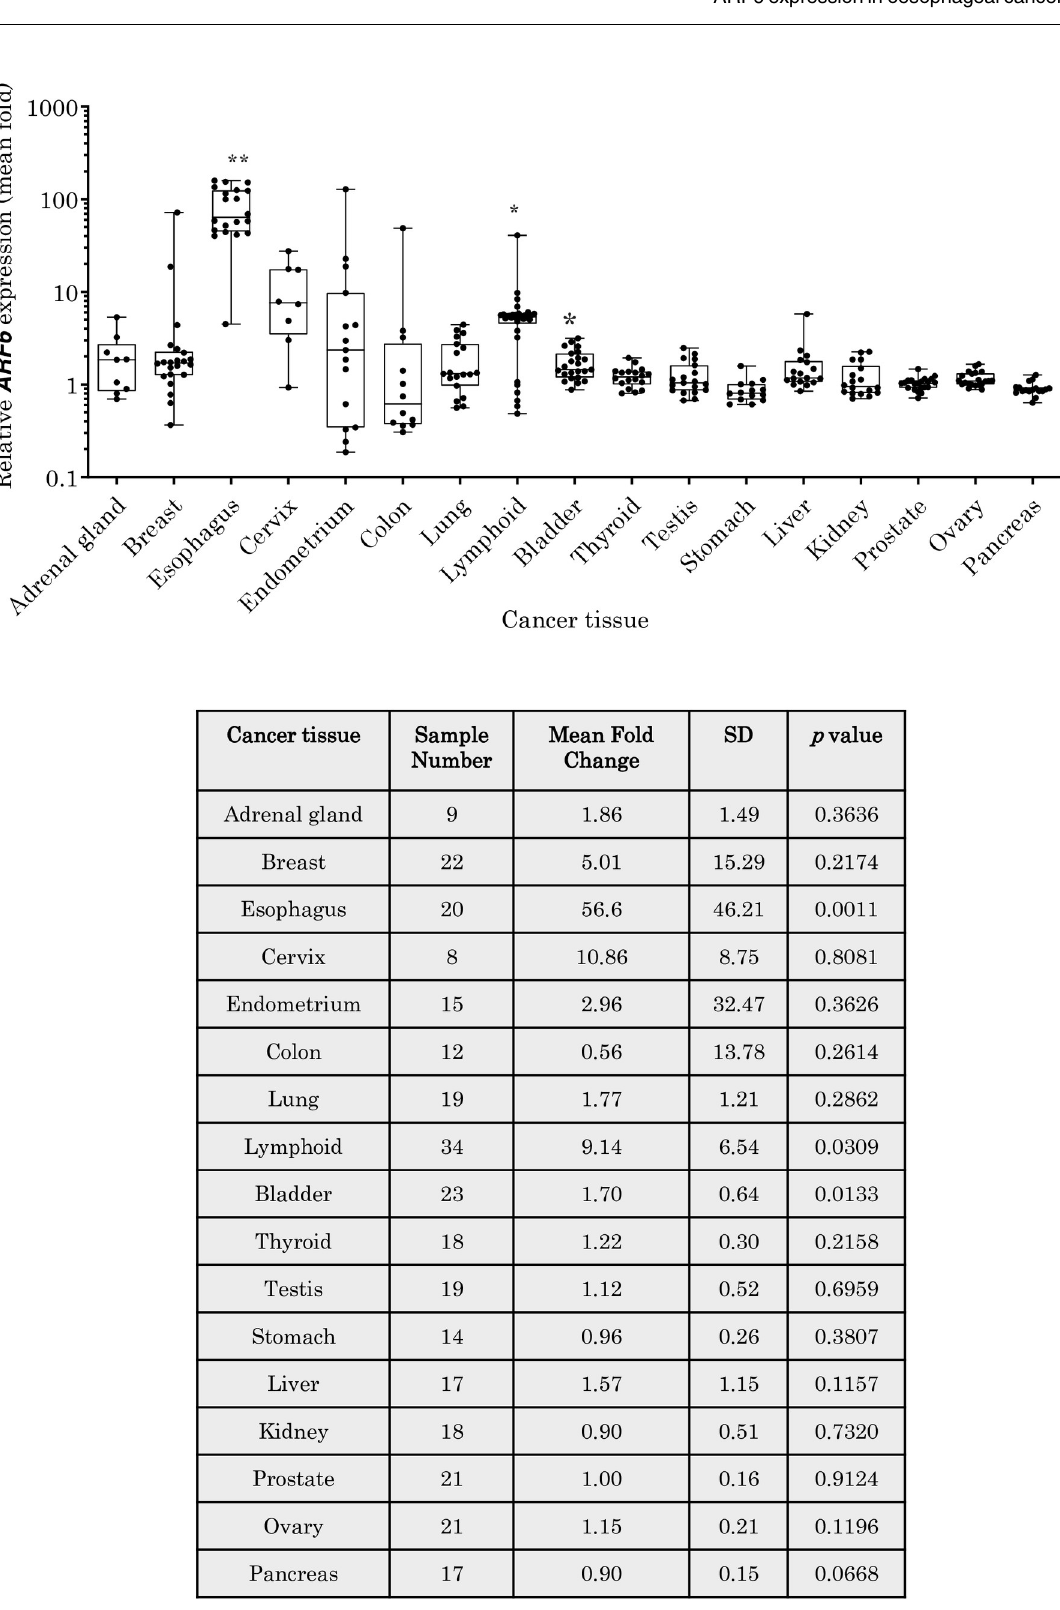
PLOS ONE | https://doi.org/10.1371/journal.pone.0263845 February 10,